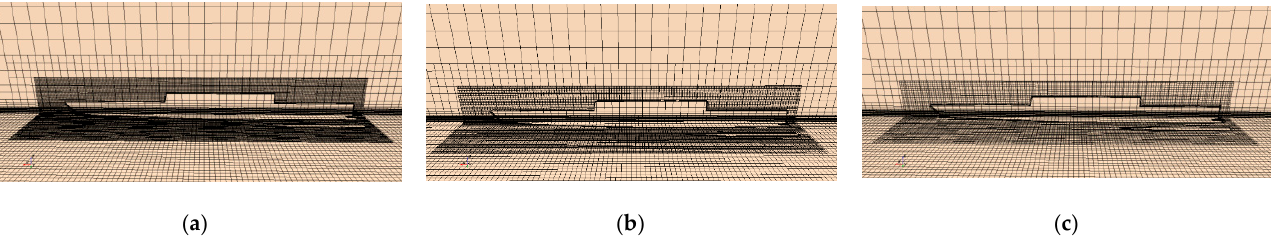
Figure 7. The three mesh cases for verification study ( a ) fine grid; ( b ) medium grid; ( c ) coarse grid.